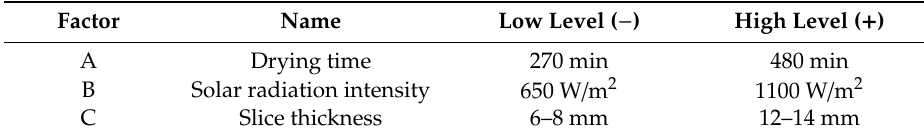
Table 1. Two-level factorial design of controllable input factors and their associated levels.